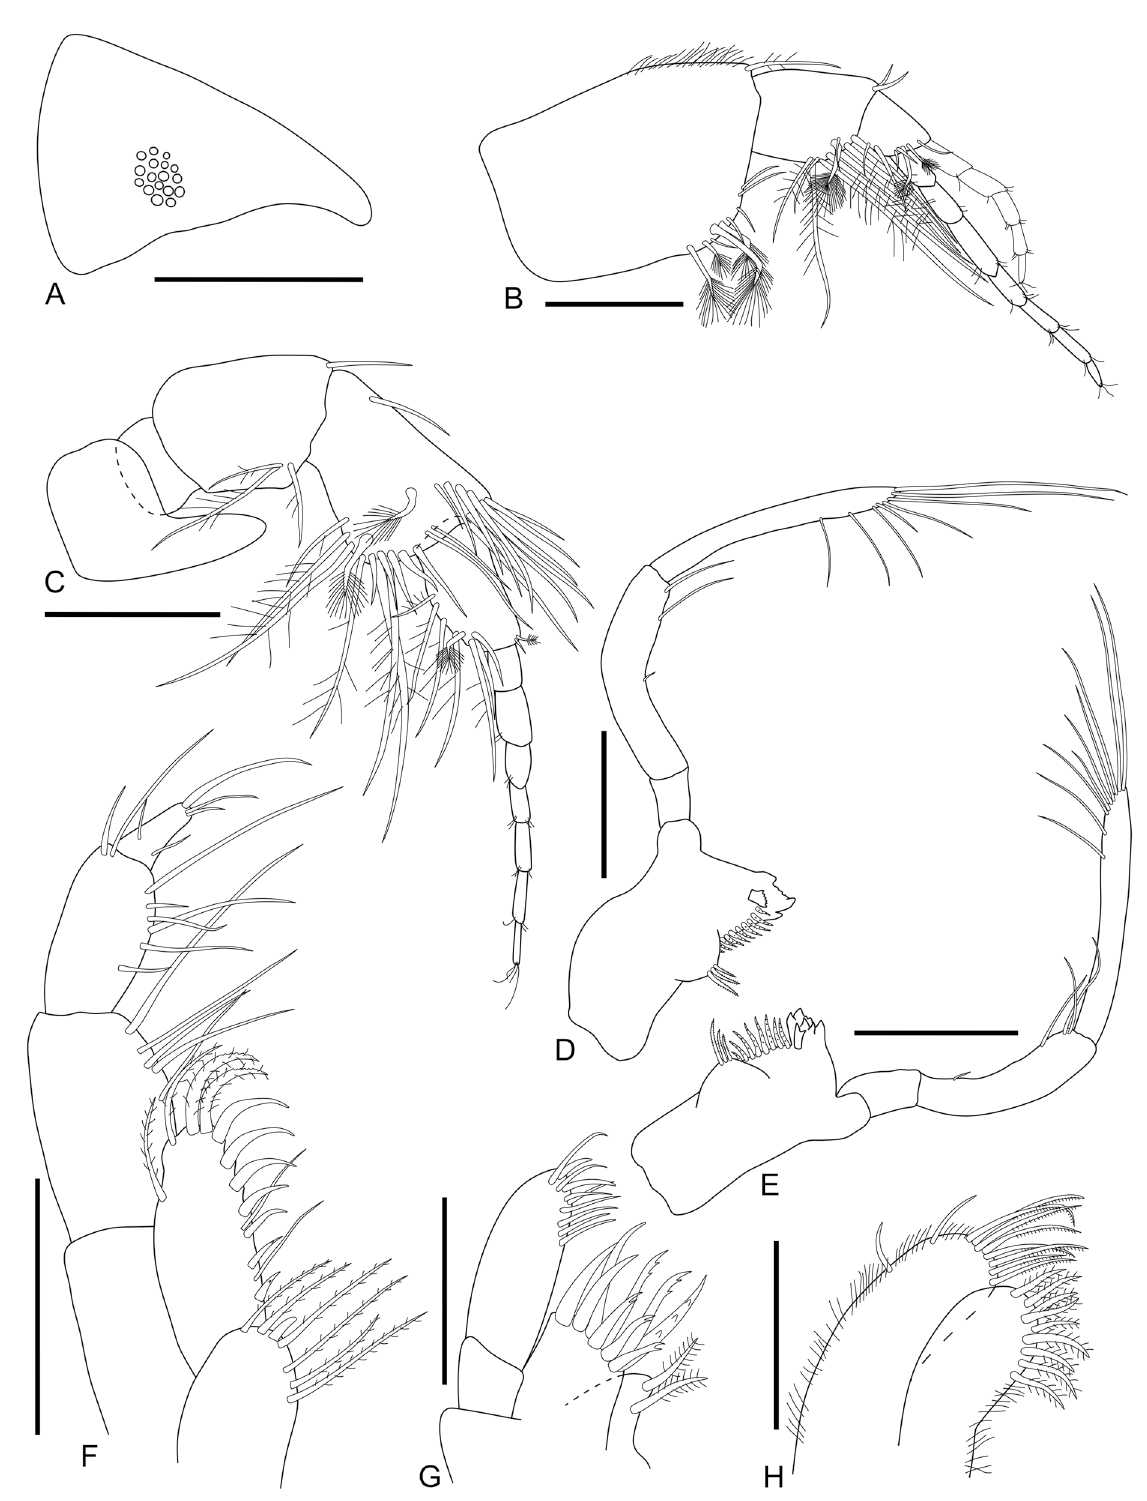
Fig. 2. Heterophoxus shoemakeri sp. nov., holotype, ♀ (UERJ 433). A . Head. B . Antenna 1. C . Antenna 2. D . Left mandible. E . Right mandible. F . Maxilliped. G . Maxilla 1. H . Maxilla 2. Scale bars: A = 0.5 mm; B–F = 0.2 mm; G–H = 0.1